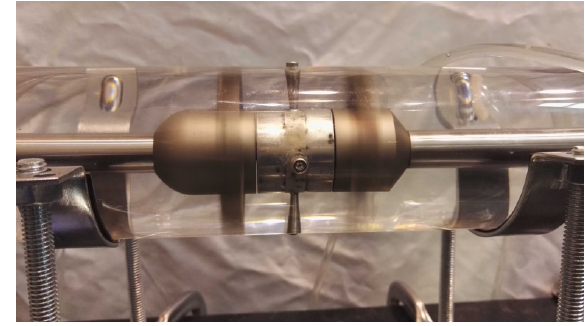
Figure 4. The picture of the experiment process, the flow direction is from left to right.